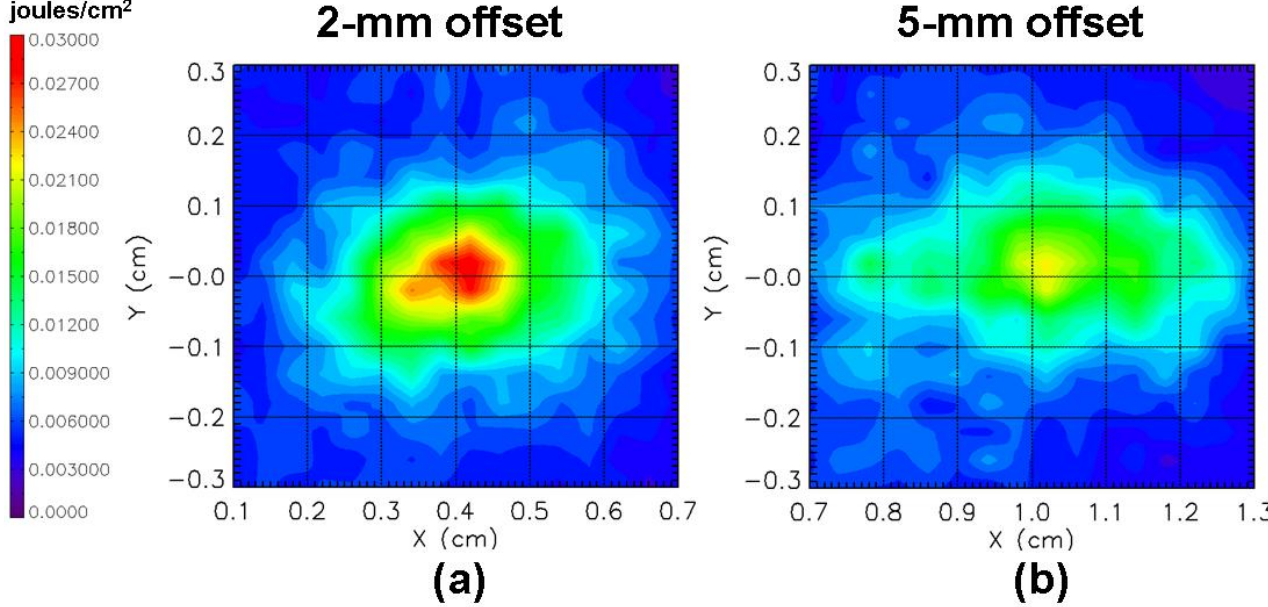
FIG. 4. (Color) The time integrated energy deposition at the target plane from the compressed beam pulse is plotted for beam offsets of (a) 2 mm and (b) 5